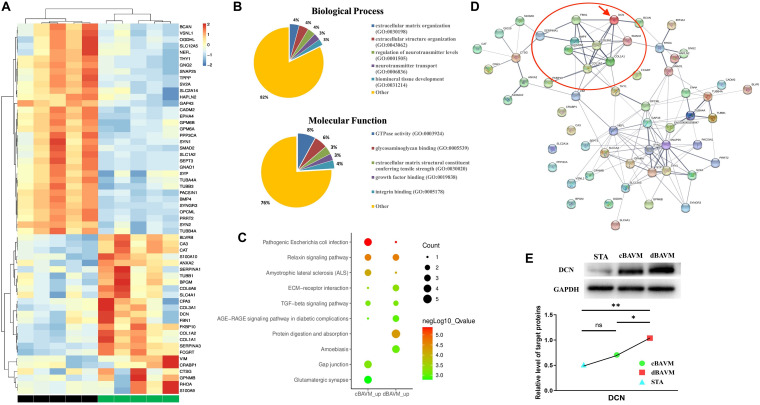
Proteome profiles of diffuse and compact brain arteriovenous malformations (BAVMs). (A) Protein expression levels in diffuse and compact BAVMs (P ≤ 0.05, fold change ≥2 or ≤0.5, and excluded the proteins with fold value of 0.5 to 2.0 between diffuse BAVMs and superficial temporal arteries). (B) The function and biological process enriched by altered protein by Gene Ontology (GO) analysis. (C) Top 10 pathways enriched by protein upregulation in diffuse and compact BAVMs by Kyoto Encyclopedia of Genes and Genomes (KEGG) analysis. (D) The protein–protein interaction network of altered proteins by STRING analysis; the decorin (DCN) was highlighted by a red arrow. The proteins interacted with DCN were highlighted by a red circle. (E) Validation of DCN expression among superficial temporal arteries, compact BAVMs, and diffuse BAVMs. A group of representative cases from each sample is shown; moreover, the level of DCN in each sample was given in Supplementary Figure 3. ∗P < 0.05; ∗∗P < 0.01; ns, P > 0.05. STA, superficial temporal arteries; cBAVMs, compact brain arteriovenous malformations; dBAVMs, diffuse brain arteriovenous malformations.